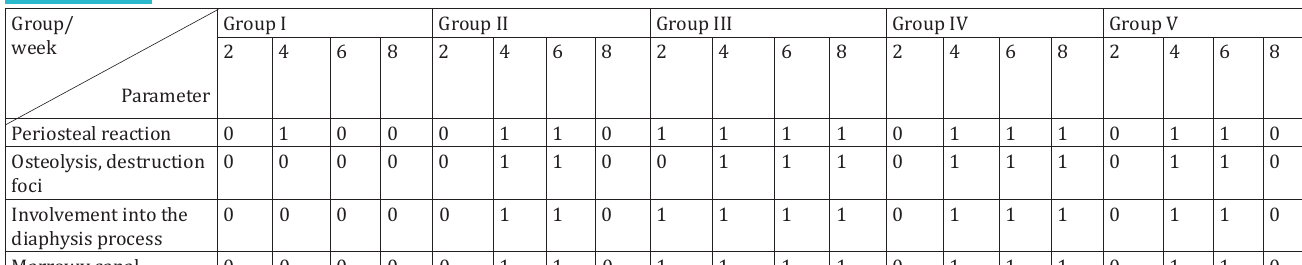
X-ray control in